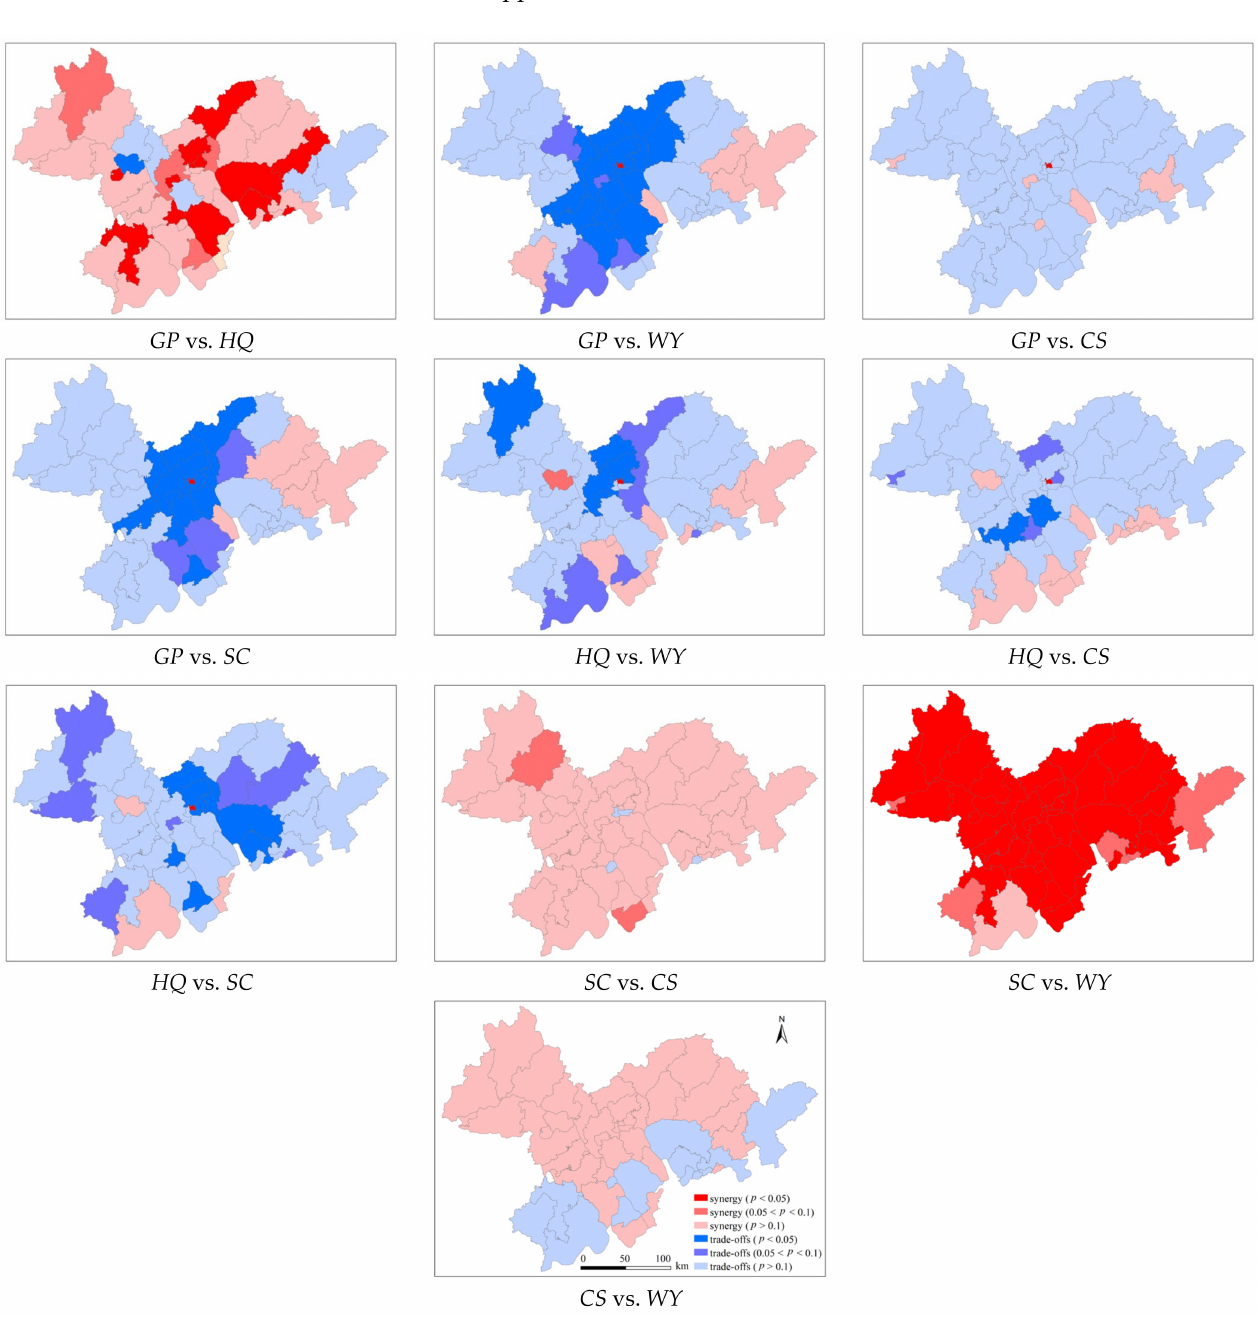
Figure 7. Spatial distribution of the ecosystem services trade-offs/synergies at the county level in the Pearl River